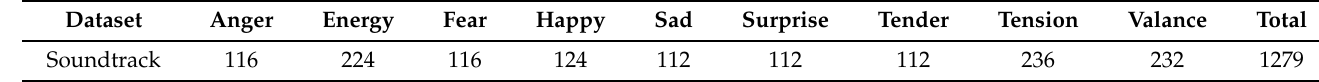
Table 4. The amount of data on Soundtrack